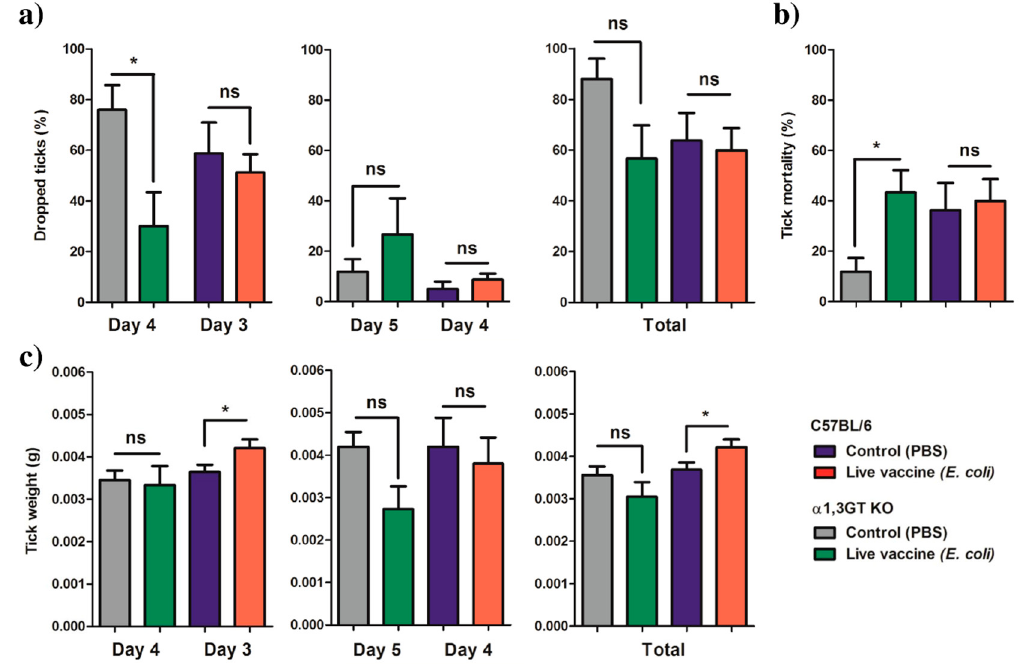
Figure 5. Performance of I. ricinus nymphs feeding on α 1,3GT KO and C57BL / 6 mice immunized with live E. coli . ( a ) The percentage of ticks that dropped on day 3, 4 or 5, and the total, was calculated and compared between groups. ( b ) The percentage of dead ticks was calculated and tick mortality (%) compared between groups. ( c ) At the end of feeding, the weight of individual ticks was measured and compared between groups. Means and standard deviation values are displayed. Results were compared within each mouse strain by Mann − Whitney U test. (* p < 0.05, ns—not significant; 1 experiment for each mouse strain, n = 12 α 1,3GT KO mice ( n = 5 ticks per mouse), n = 10 C57BL / 6 mice ( n = 20 ticks per mouse)).